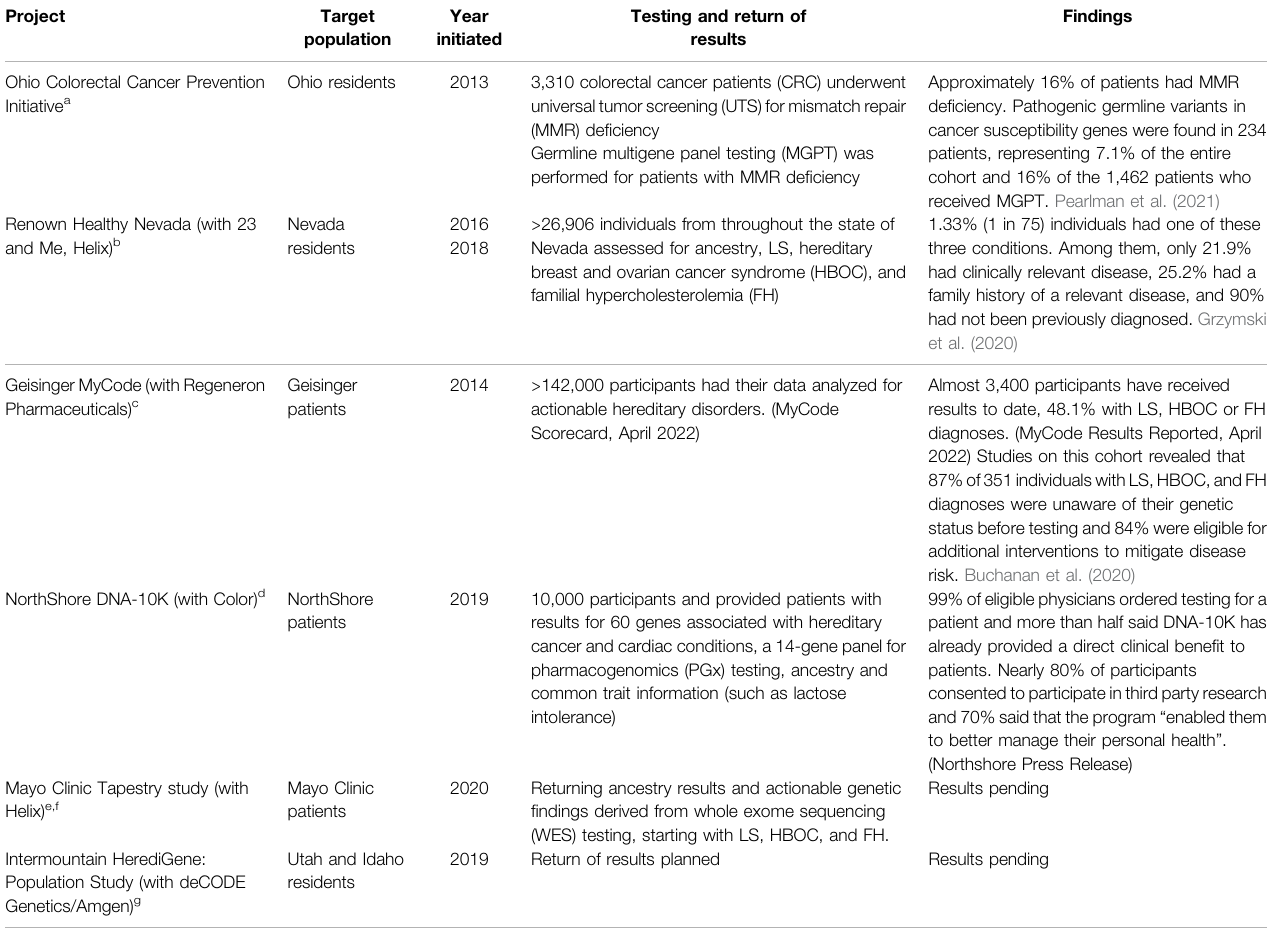
TABLE 1 | Selected population genomic screening